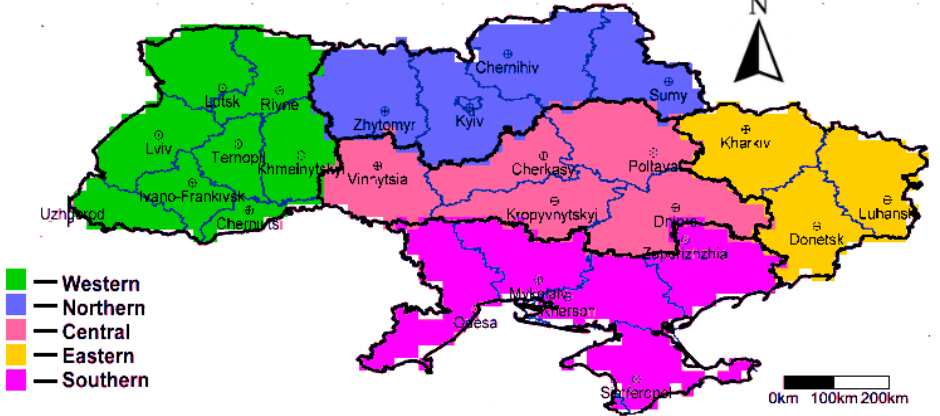
Figure 1. Climate zones of Ukraine (Source: adapted from [57]).